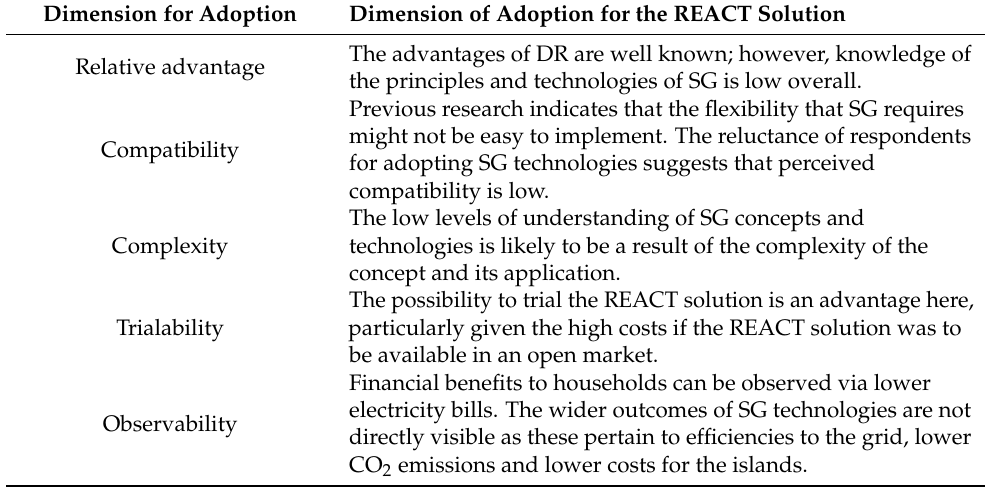
Table 3. Dimensions of technology adoption for the REACT